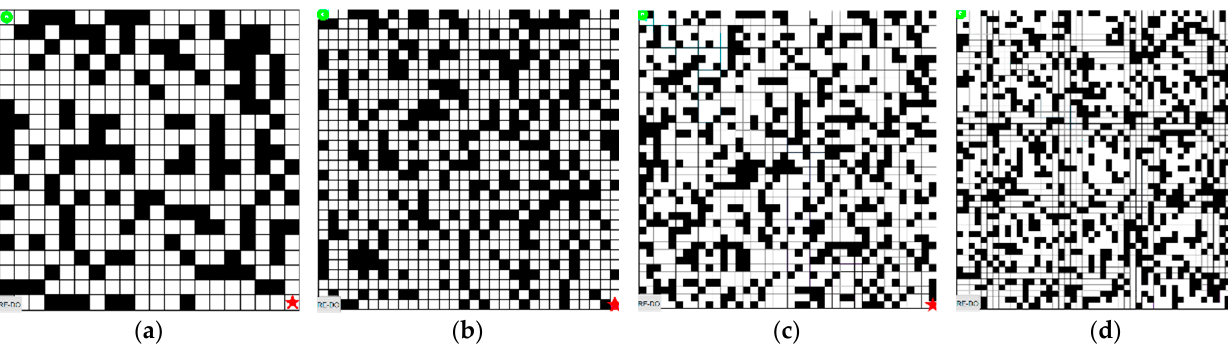
Figure 3. Obstacle environment maps with di ff erent numbers of grids: ( a ) grid size 20 × 20, start point coordinates (1, 20), end point coordinates (20, 1); ( b ) grid size 30 × 30, start point coordinates (1, 30), end point coordinates (30, 1); ( c ) grid size 40 × 40, start point coordinates (1, 40), end point coordinates (40, 1); and ( d ) grid size 50 × 50, start point coordinates (1, 50), end point coordinates (50, 1).